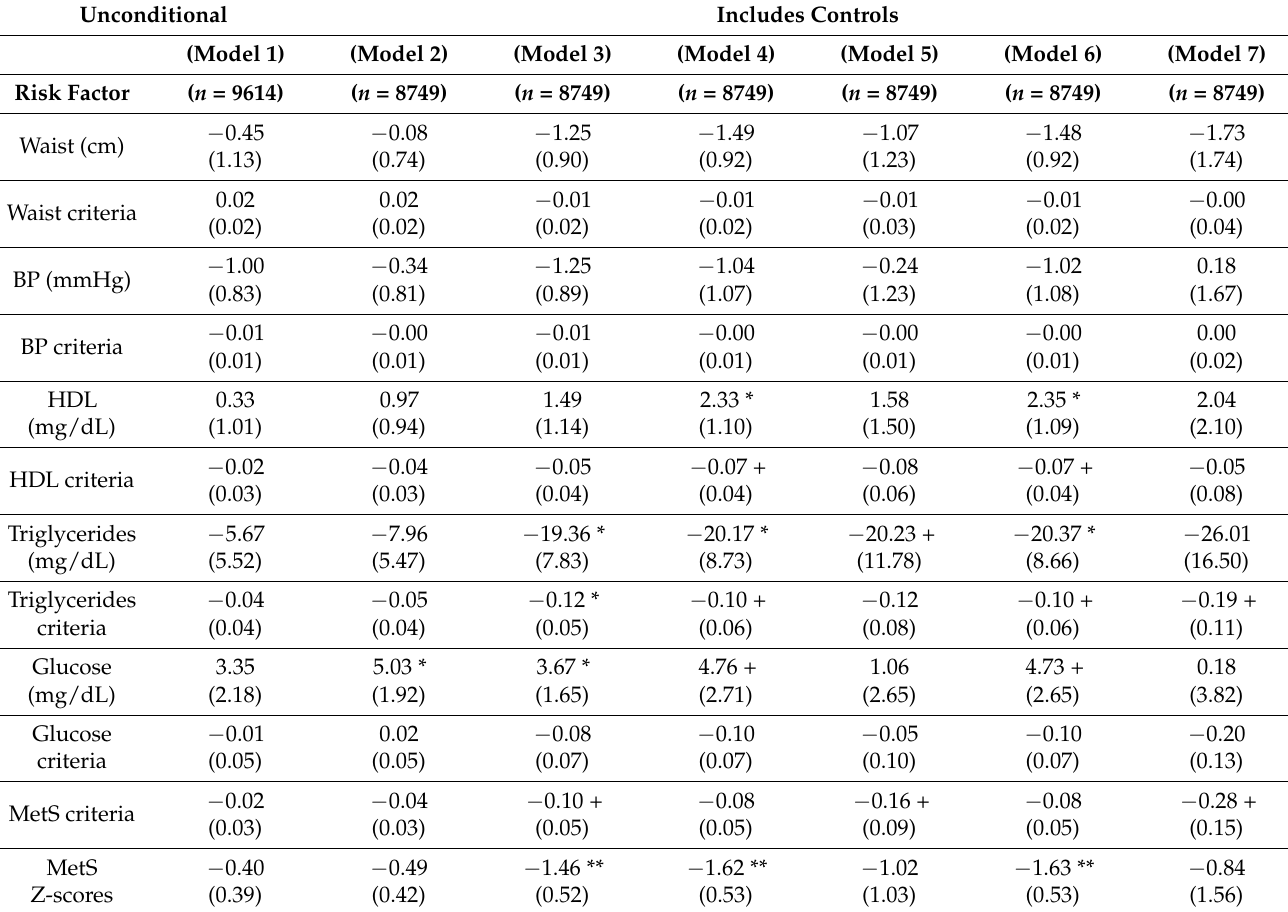
Table A2. Estimated effect of SNAP eligibility on cardiometabolic risk factors in children and adolescents compared to those just over the eligibility threshold: different functional forms. (Model 1 is an unconditional model that centers PIR on 1.30 but does not allow the slope to vary on either side of the 1.30 PIR cutoff. Model 2 is the same as Model 1 (i.e., slopes do not vary) but controls for youth-specific characteristics (age, sex, race, food-security status, and participation in nutrition assistance programs) and household-level controls (HR education, HR marital status, HH size). Models 3 through 7 also include these controls. Model 3 adds an interaction term between the SNAP treatment variable and has a centered PIR, which allows the slope to vary on either side of the PIR cutoff. Model 3 is the same model as the main model presented in the manuscript for the pooled sample (Table 2, Column 1), but adds controls. Model 4 is a quadratic model that includes PIR (centered on 1.30) and centered PIR 2 . Model 5 is a quadratic interaction model that includes centered PIR, centered PIR 2 , and interactions between the SNAP treatment variable and both PIR and PIR 2 . Model 6 is a cubic model in which the slopes are identical on either side of the PIR cutoff, but it includes cubic PIR. Model 7 is a cubic interaction model that includes cubic PIR and allows the slopes to vary on either side of the cutoff. These different functional forms mirror those described by Jacob et al.